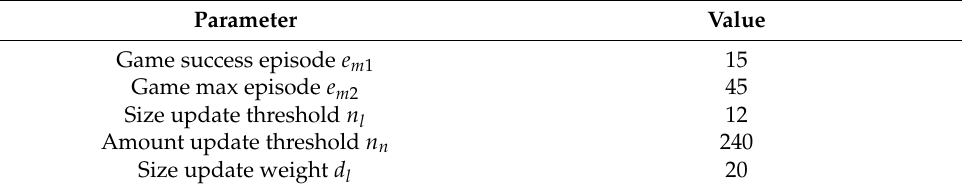
Table 2. Parameter of environment